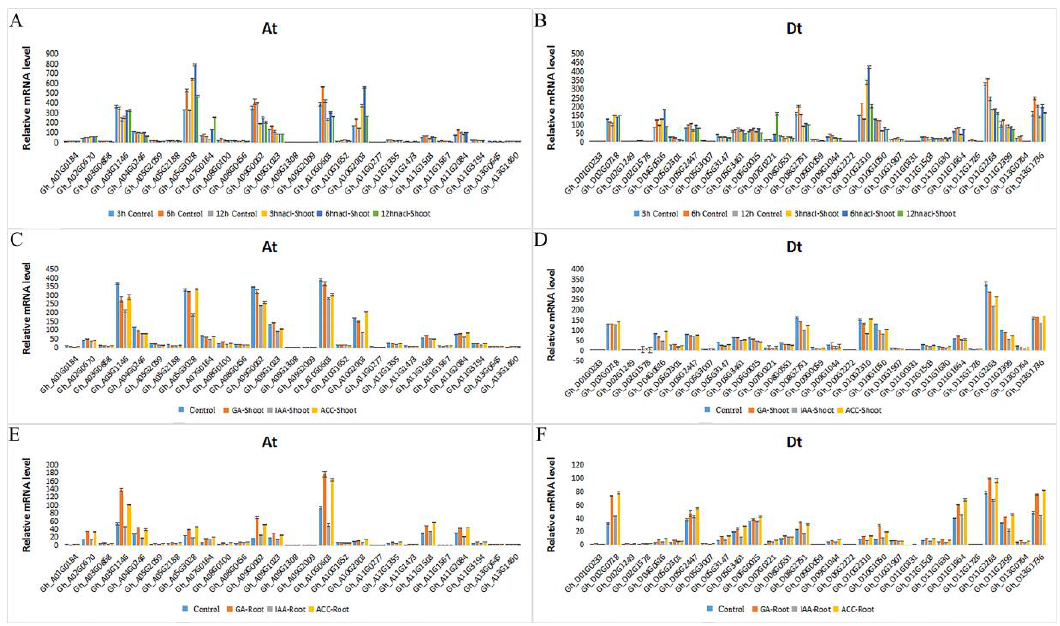
Figure 7. Expression profile analysis of GhRCC1 genes’ response to salt and drought stress. Gene expression analysis of the GhRCC1 family in cotton seedlings grown for 10 days. ( A ) Expression pattern of GhRCC1 At subfamily gene after treatment of cotton seedlings for 3, 6, and 12 h with 200 mM NaCl. ( B ) Expression pattern of the GhRCC1 Dt subfamily gene after treatment of cotton seedlings for 3 h with 200 mM NaCl. ( C ) Expression profiling of the GhRCC1 At subfamily genes and ( D ) Dt subfamily genes in shoots treated with 17% PEG6000. ( E ) Expression profiling of the GhRCC1 At subfamily genes and ( F ) Dt subfamily genes in roots treated with 17% PEG6000. Error bars represent standard deviations from three biological replicates.